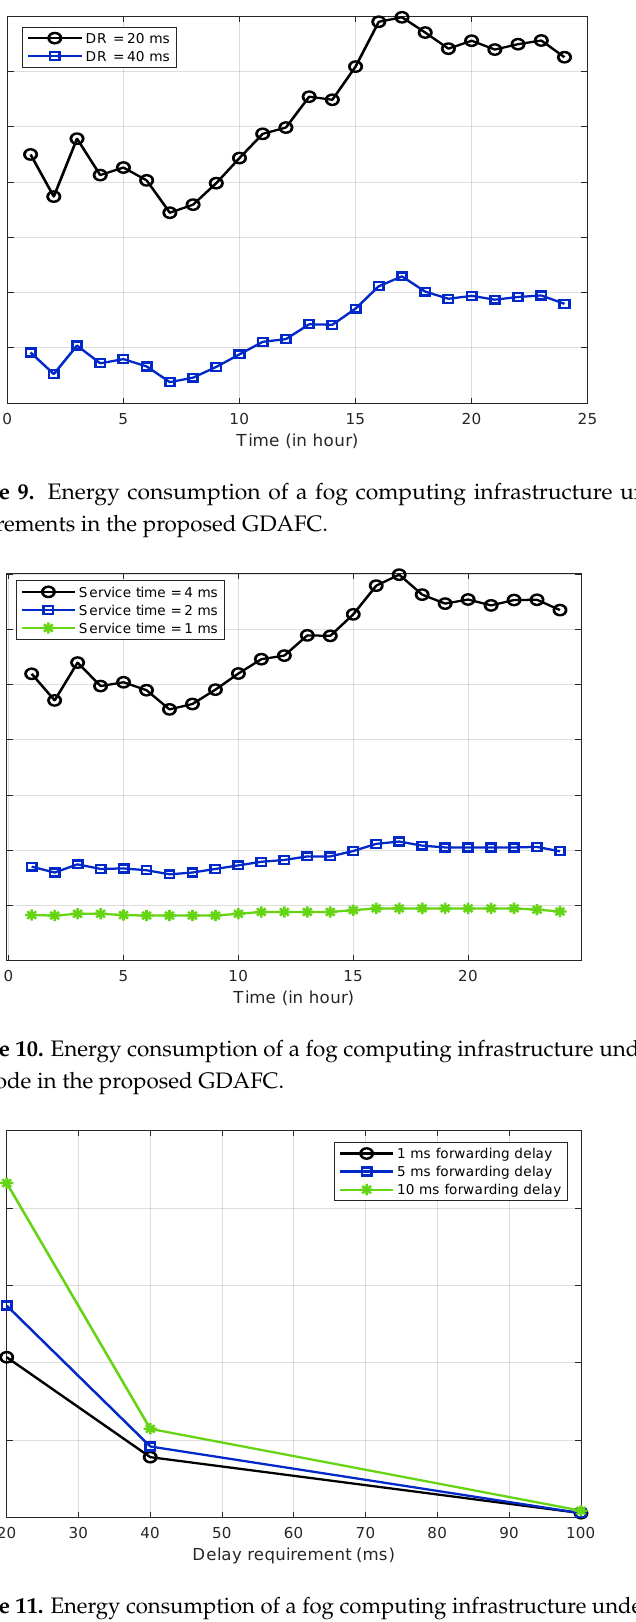
Figure 11. Energy consumption of a fog computing infrastructure under different forwarding delays in the proposed